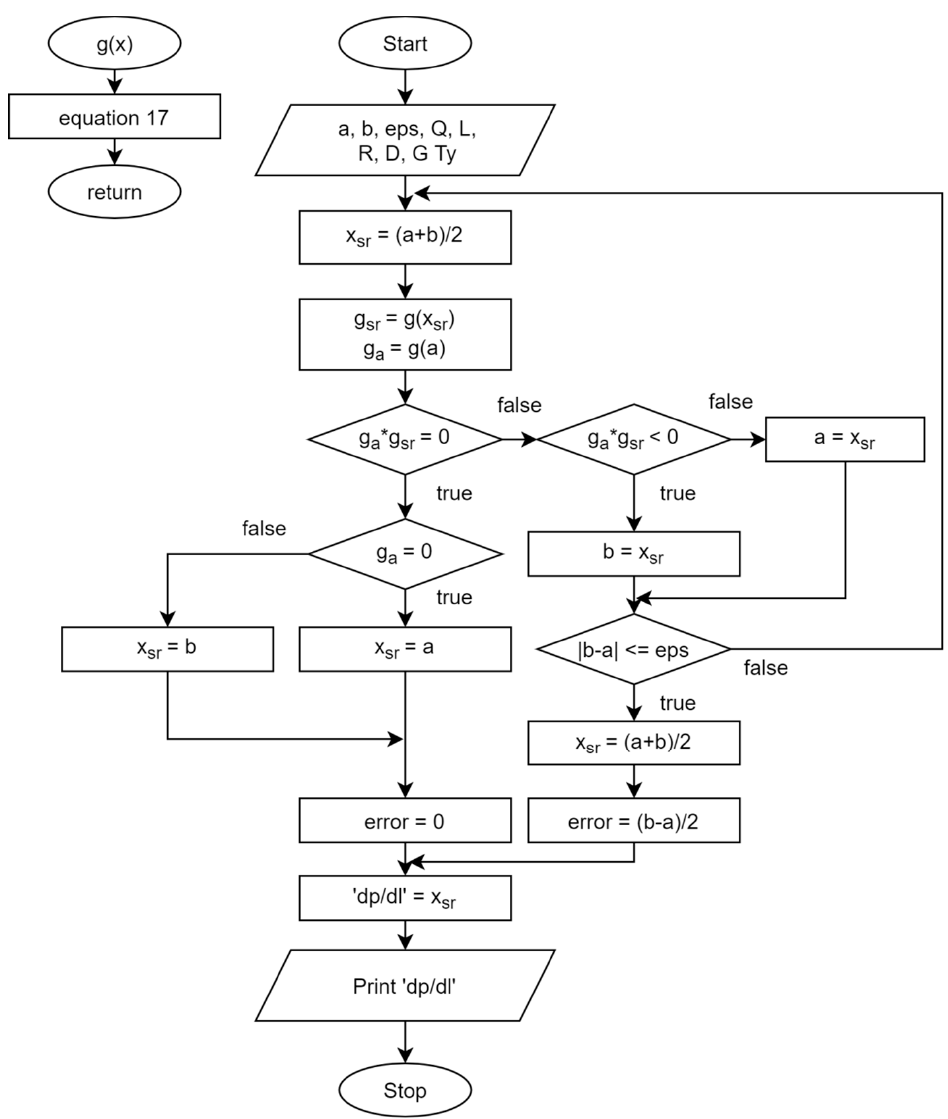
Figure 3. Block diagram for the calculation of root of the g(x) function being in the range [a, b] by means of the bisection method.